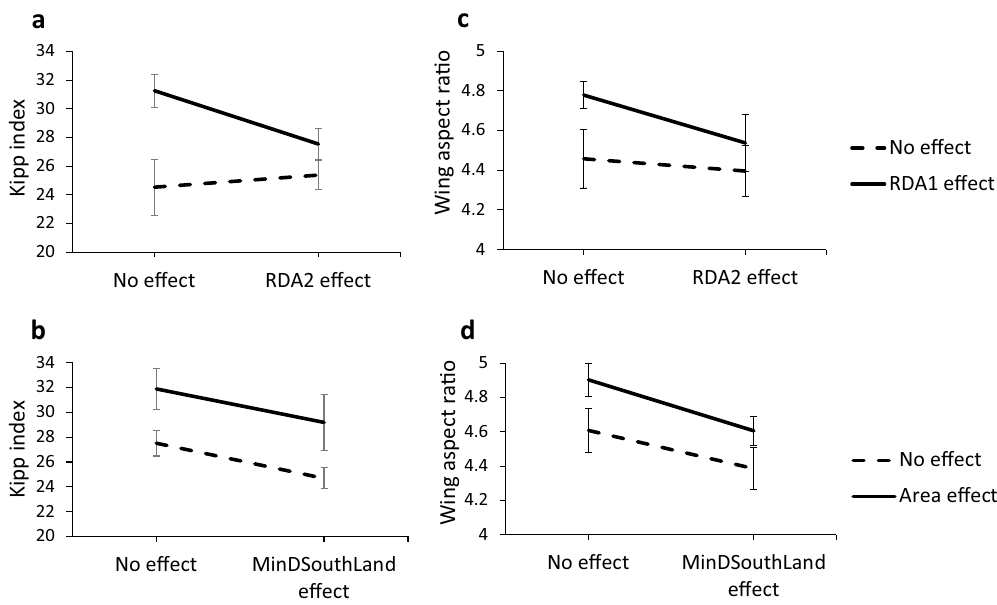
Figure 5. Mean (± SE) Kipp index ( a ) and wing span ratio ( c ) for species classified as presenting a significant negative correlation with RDA1 or RDA2 or not (No effect) (Table 4). Mean (± SE) Kipp index ( b ) and wing span ratio ( d ) for species classified as having a significant positive effect of the variables area or MinDSouthLand on its abundance index or not (No effect) (Table 3S). Minimum values in Y axis of both variables correspond approximately to the values for two short distance migrant species ( Erithacus rubecula and Phylloscopus collybita